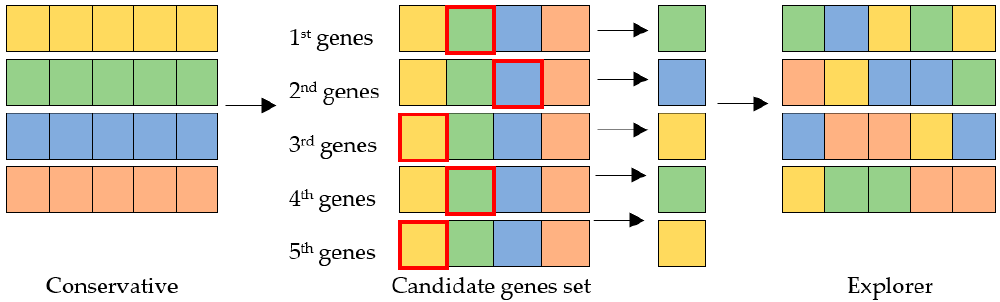
Figure 5. Mechanism for generating explorer chromosomes. Only one example of a randomly generated explorer chromosome is shown in the middle panel. Red lines indicate which gene from each position was chosen.